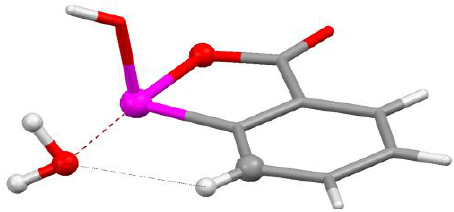
Figure 7. Fragment of crystal structure of 1-hydroxy-2,1λ 5 -benzoxarsol-3-one monohydrate. Colors: red = oxygen, pink = arsenic, white = hydrogen, gray = carbon. Dashed lines show As---O σ-hole interaction and C–H---O hydrogen bond.